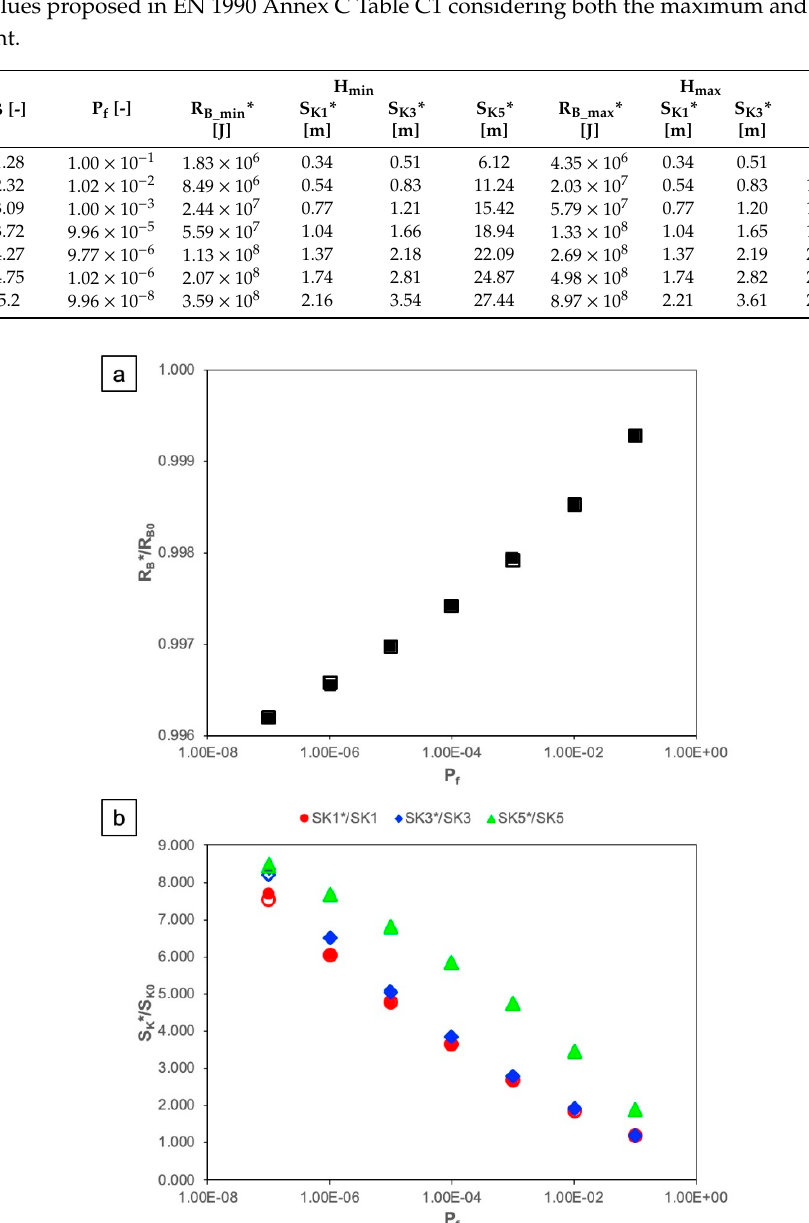
11 of 16 Table 4. Design parameters evaluated for a reliability-based design approach as a function of reliability index values proposed in EN 1990 Annex C Table C1 considering both the maximum and minimum fall height. β [-]